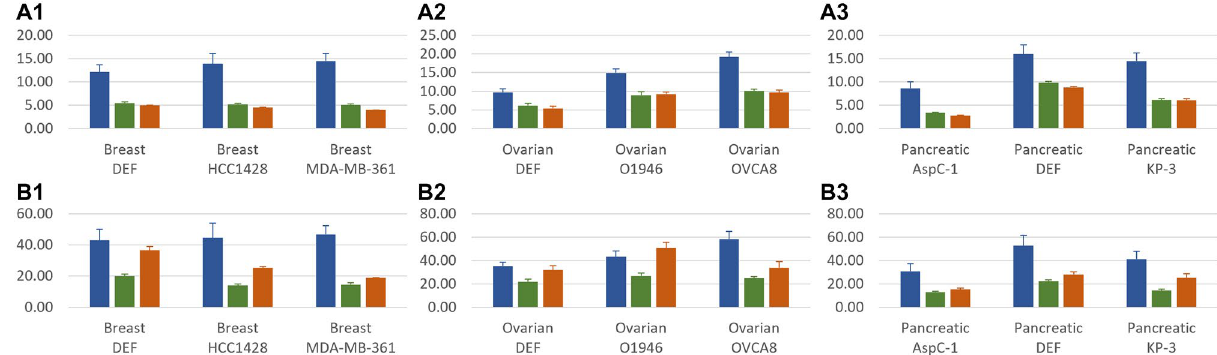
Figure 3. The results of the algorithms on the biological networks. ( A ) Number of identified drug-targetable inputs, ( B ) number of targets controllable from the identified drug-targetable inputs; column 1: breast cancer networks, column 2: ovarian cancer networks, column 3: pancreatic cancer networks; in blue: (constrained) genetic algorithm, in green: constrained greedy algorithm, in orange: unconstrained greedy